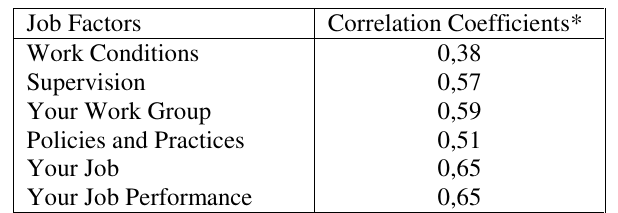
RELATION BETWEEN GENERAL JOB SATISFACTION AND JOB FACTOR